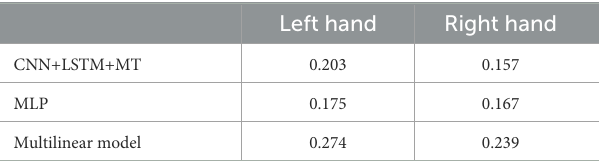
TABLE 4 Differences between models trained on sessions 0–6 and 30–36 in the dataset translation